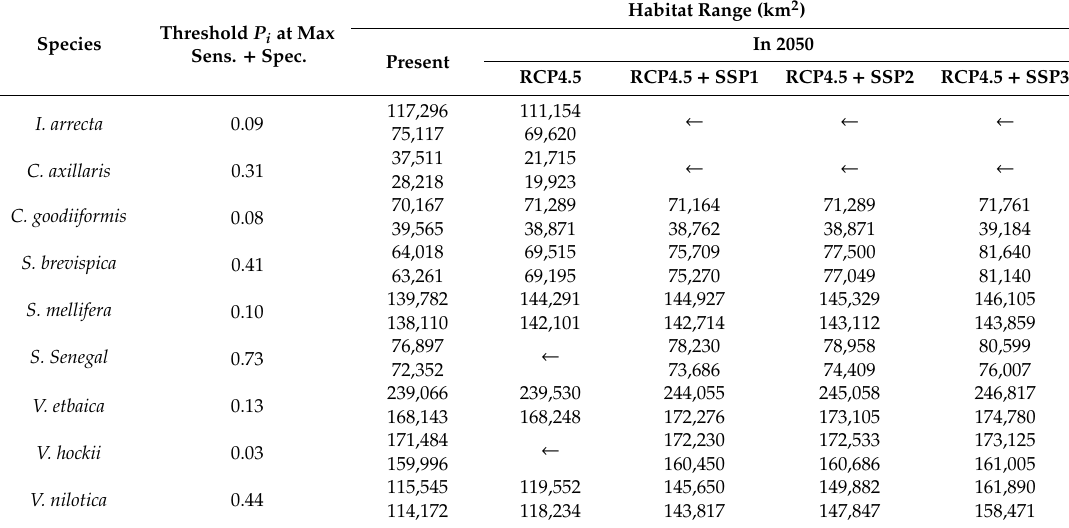
Table 5. Current and future species ranges at highest sum of sensitivity and specificity. First row represents potential area, while second row represents extent of occurrence area. Threshold P i at Max Species Sens. + Spec.